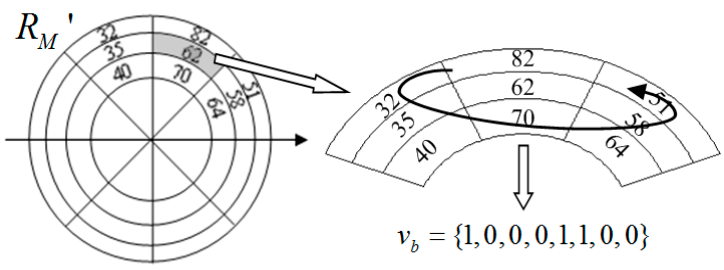
Figure 5. The extraction of the hash values from a block.